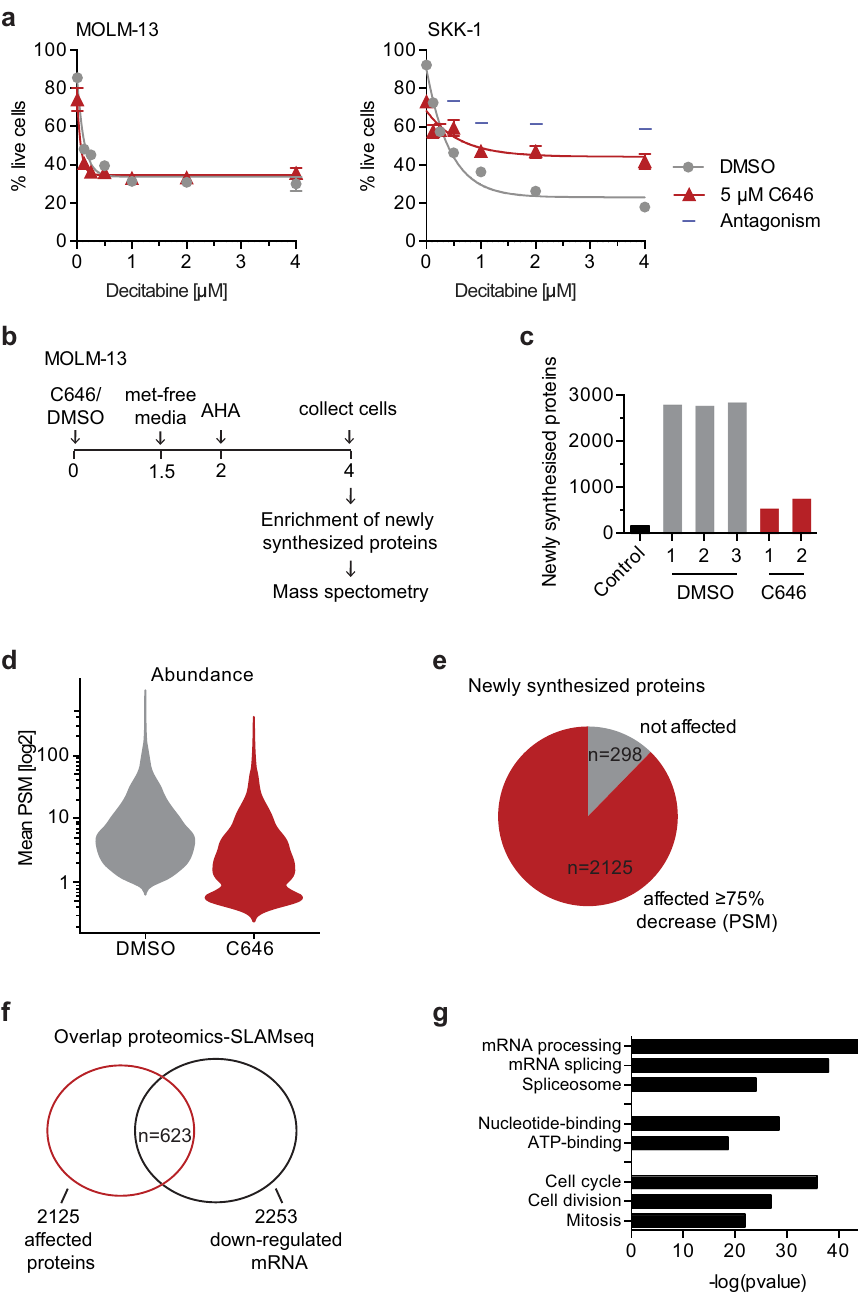
Fig. 4 CBP/p300 inhibition reduces protein synthesis but does not synergize with decitabine. a Percentage of live MOLM-13 or SKK-1 cells after 4 days of treatment with indicated concentrations of AZA in combination with 5 µ M decitabine or DMSO (0.05%) as vehicle control. Data represent the mean ± SEM of four independent experiments. Statistical analysis was performed using two-way ANOVA. Calculating the combination index (CI)